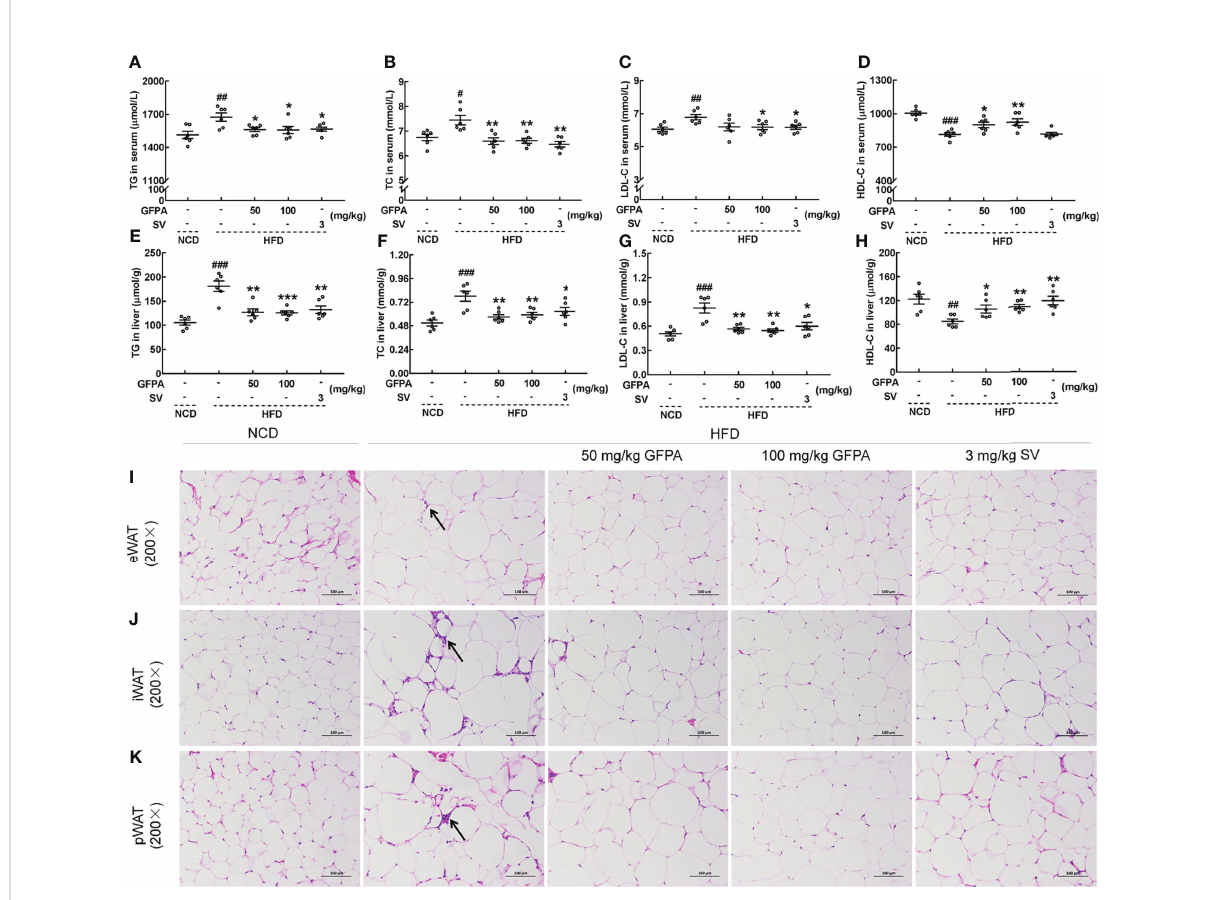
FIGURE 3 GFPA suppressed hyperlipidemia in mice with DIO. Eight weeks of GFPA administration decreased the concentrations of (A) TGs, (B) TC and (C) LDL-C and increased the concentration of (D) HDL-C in the sera of HFD-fed mice. Eight weeks of GFPA administration decreased the concentrations of (E) TGs, (F) TC and (G) LDL-C and increased the concentration of (H) HDL-C in the livers of HFD-fed mice. Data are expressed as means ± S.E.M. (n = 6). # p < 0.05, ## p < 0.01 and ### p < 0.001 versus NCD-fed mice; * p < 0.05, ** p < 0.01 and *** p < 0.001 versus HFD-fed mice. Pathological alterations in (I) eWAT, (J) iWAT and (K) pWAT were evaluated by H&E staining (magni fi cation: 200×;